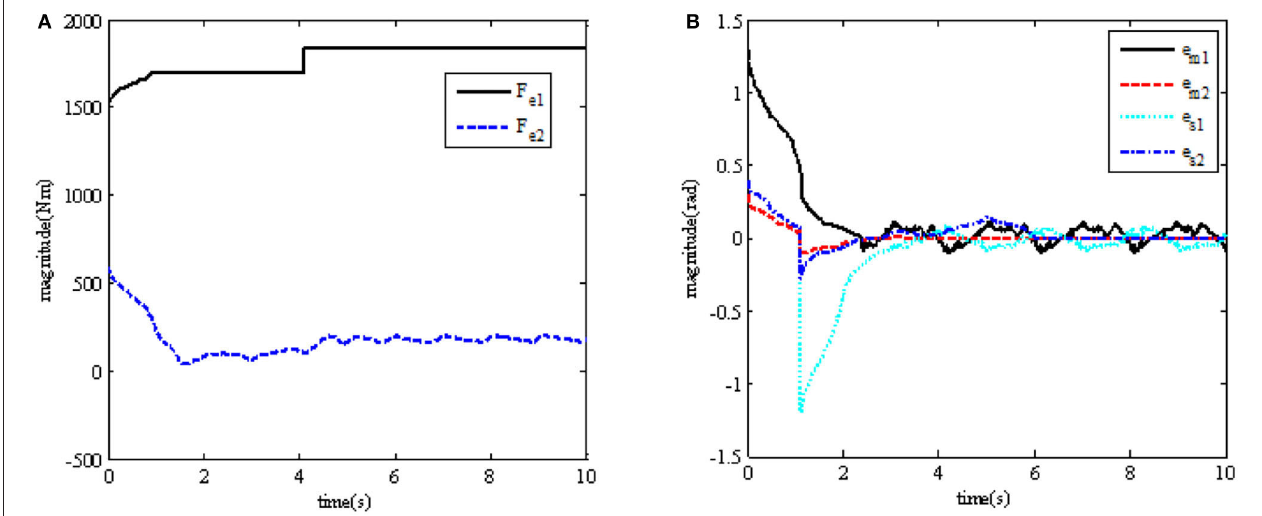
FIGURE 4 | Simulation results after the change of external force F e . (A) From the interaction, F e between the robot and the environment; (B) position tracking error of master and slave robots’ joints.